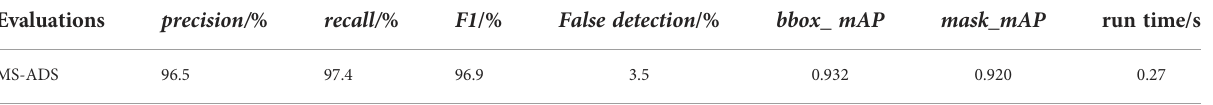
TABLE 2 Detection and instance segmentation results of apples on test